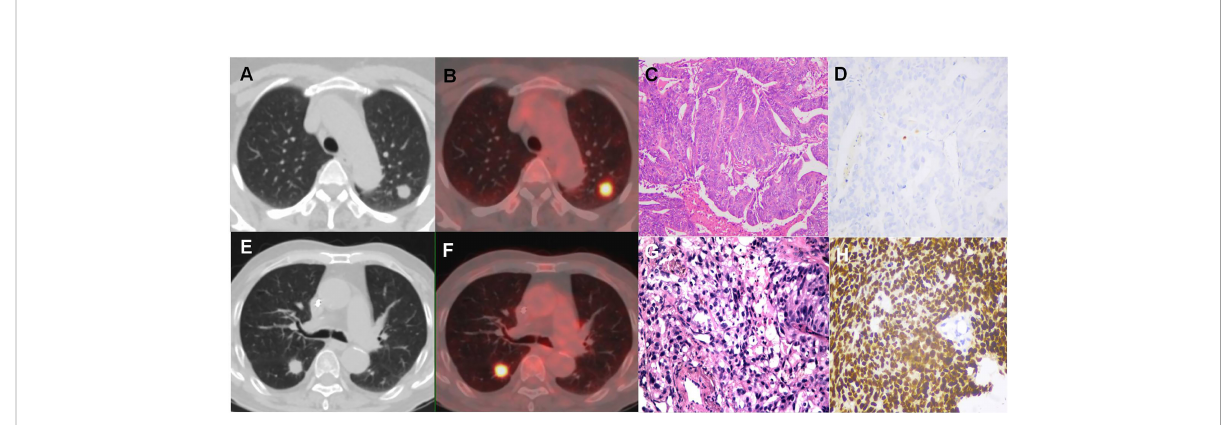
FIGURE 5 18 F-FDG PET/CT fi ndings of LM and LC of CRC patients. (A, B) 49y female was diagnosis sigmoid colon cancer. 18F-FDG PET/CT showed a circular soft tissue nodule in upper lobe of the left lung, which with smooth margin and high FDG uptake on CT and integrated PET-CT. The nodule was histopathologically con fi rmed to be LM; (C, D) The hematoxylin-eosin staining (200x) showed that the adenocarcinoma cells grew in fi ltratively with clear cytoplasm. Immunohistochemistry was negative for TTF-1; (E, F) 71y male was diagnosis sigmoid colon cancer. 18 F-FDG PET/CT showed a circular soft tissue nodule of high FDG uptake in inferior lobe of right lung, which with spiculated margin and pleural tags on CT and integrated PET/CT.; The nodule was histopathologically con fi rmed to be LC; (G, H) The hematoxylin-eosin staining (200x) showed that adenocarcinoma cells are con fl uent, cribriform in fi ltrative, and necrotic tissue can be seen. Immunohistochemistry showed TTF-1